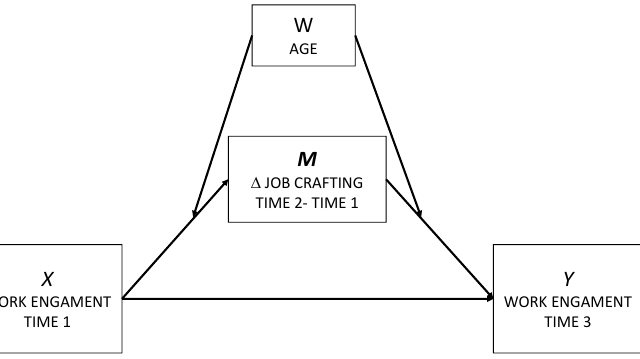
Figure 1. Global model for this study applying the Model nº 58 from Hayes.